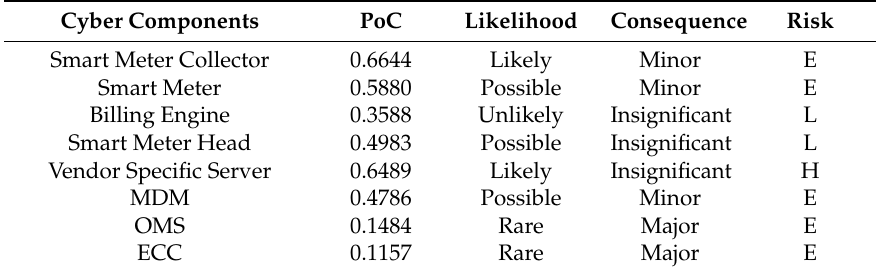
Table 5. Risk levels of the cyber components of the smart grid. MDM, Meter Data Management; OMS, Outage Management System; ECC, Electricity Control Center; PoC, Probability of